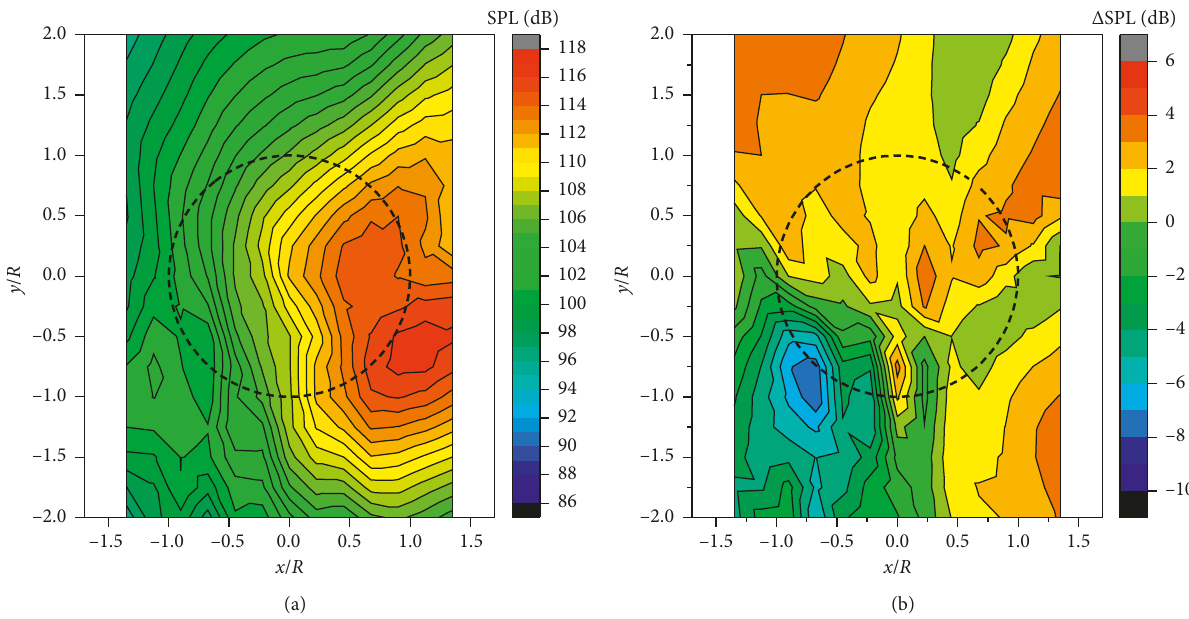
Figure 12: Midfrequency (6th–40th) BVI noise directivity pattern of the ECR with 8 ∘ pre-index angle. (a) Predicted SPL noise contours; (b) difference of SPL between ECR with 8 ∘ and 6 ∘ pre-index angle.